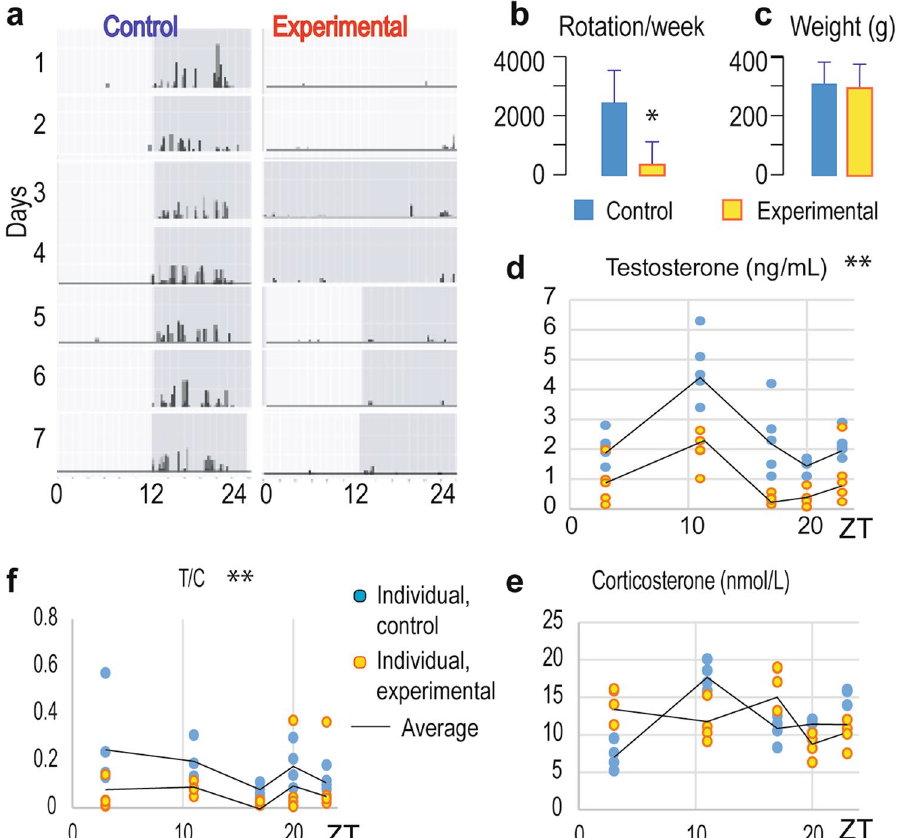
Figure 1. The CD changed daily activity pattern and reduced testosterone blood level. Adult rats were housed under the controlled light regime of 12 h light–12 h dark (control) or were exposed to a disturbing light regime (2 days of continual light, 2 days of continual dark, and 3 days of 12:12 h light:dark schedule; experimental) for 2 months. The voluntary activity was monitored, and actograms were formed. The representative weekly actogram from control and experimental rats ( a ) as well as average weekly activity ( b ) and body mass ( c ) in the last week of the experiment are shown in bars ± SEM values (n = 25; 5 rats in 5 time points). The experimental conditions reduced diurnal fluctuations of serum testosterone (determined in ZT3, ZT11, ZT17, ZT20, ZT23; ZT0 is time when light switch on) ( d ), flattened the daily profile of corticosterone levels in serum ( e ), and reduced testosterone/corticosterone (T/C) ratio ( f ). For rhythm parameters, please see Suppl. Table 2. ZT is zeitgeber time, i.e., the time when the light switches on. In ( d – f ) panels of this figure and all others figures data points represent individual values, while the black line represents group means values (n = 5). **Statistical significance p < 0.01 determined by two-way ANOVA; *statistical significance p < 0.05 determined by Mann– Whitney